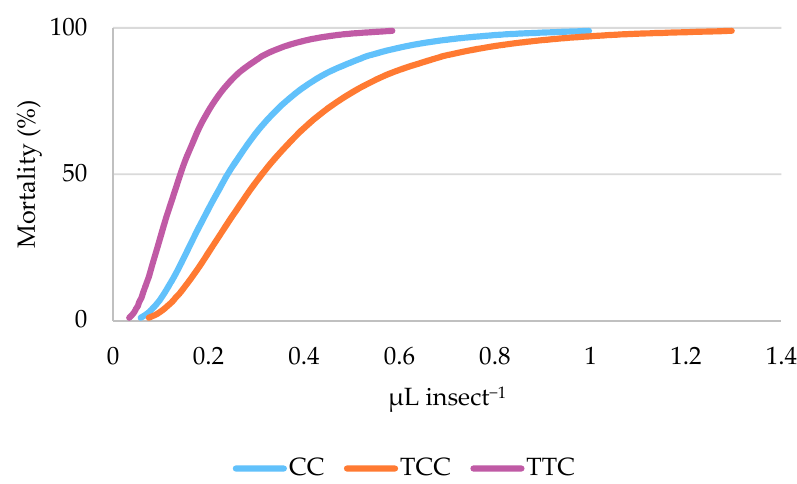
Figure 2. Dose–effect relationship of the mortality (mortality %) of adults of the synanthropic fly Calliphora vomitoria exposed by contact to carvacrol (CC), thymol/ p -cymene (TCC), and thymol/ γ -terpinene (TTC) oregano chemotypes essential oils as predicted by the Probit model. The RMP analysis showed significant differences in toxicity between TTC and CC (RMP = 0.586, CI = 0.442–0.736), between CC and TCC (RMP = 0.770, CI = 0.633–0.917), and between TTC and TCC (RMP = 0.451, CI = 0.322–0.586) against adult C. vomitoria flies. Toxicity tests on C. vomitoria eggs showed the different toxicity of the EOs with the three oregano chemotypes (ANCOVA, F 2,43 = 79.649, p < 0.001) (Figure 3).